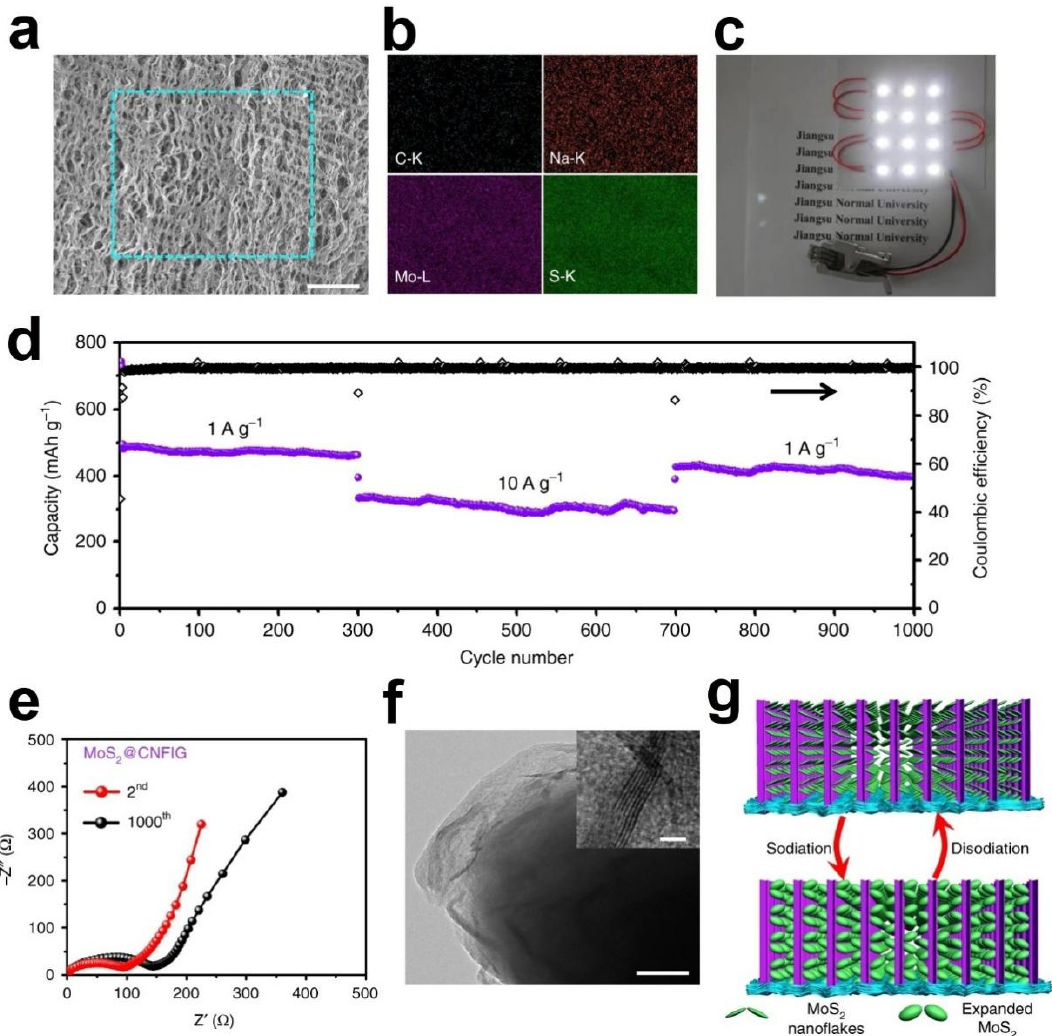
Figure 21. ( a ) SEM image (scale bar = 50 μ m) and ( b ) corresponding EDX elemental mappings (C, Na, Mo, and S) of MoS 2 @CNFIG anode after 1000 cycles; ( c ) Three assembled full cells based on MoS 2 @CNFIG anodes in parallel powering the 12 LEDs; ( d ) Long-term cycling ability and Coulomb efficiency of the full cell at 1 and 10 A g − 1 ; ( e ) Nyquist plots of the full cell after 2 and 1000 cycles; ( f ) TEM image of the full cell after 1000 cycles with the scale bar of 50 nm and 2 nm (inset in ( f )); ( g ) Schematic illustration of porous space of CNFIG provided the volume expansion space for MoS 2 nanoflakes. Reproduced with permission [118]. Copyright 2019, Springer Nature.